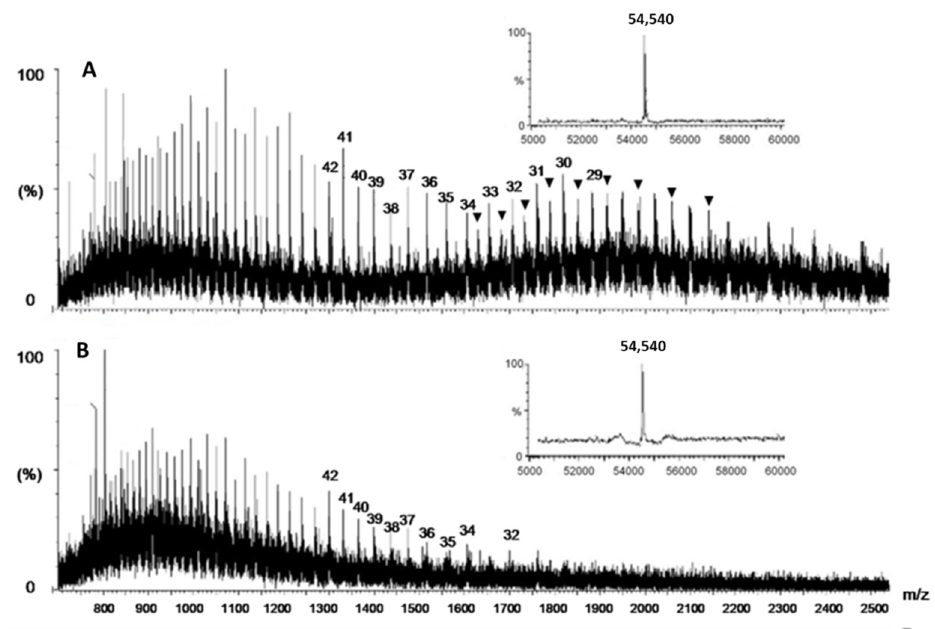
Figure 4. The mass spectra of HCV NS3 proteins produced at 25 °C ( A ) and 37 °C ( B ) . They are plots of ion intensity vs. m/z (mass-to-charge ratio). The deconvolution of the spectra (inset) give the same molar mass of 54,540 atomic mass units. Numbers above the peaks stand for the z value (charge state) of the monomeric protein, and triangle labels are the signals specific to the dimeric protein.